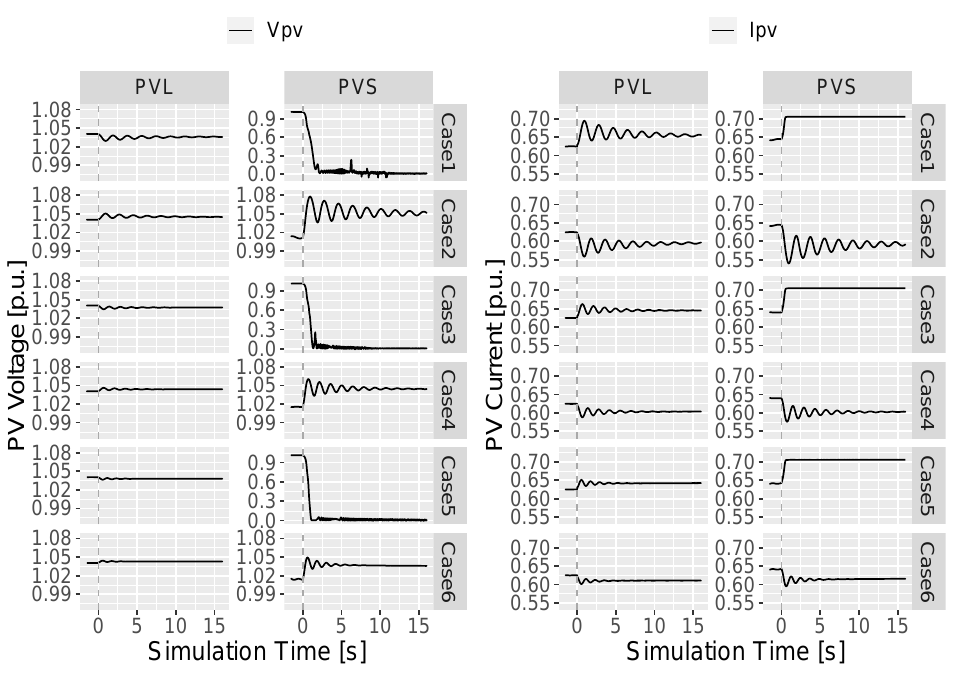
Figure 10. Voltage and current of PV.